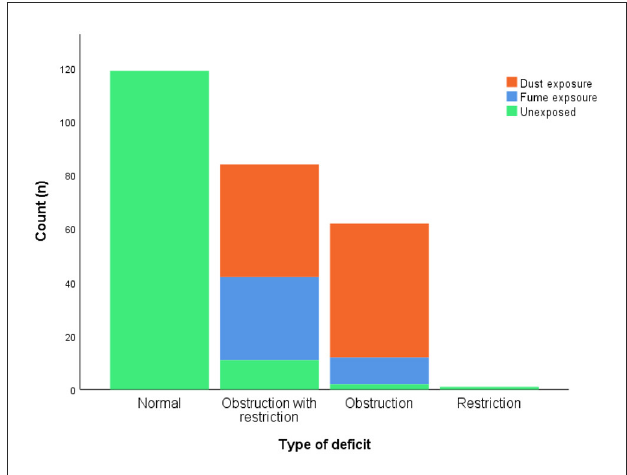
FIGURE1 Prevalence of lung function